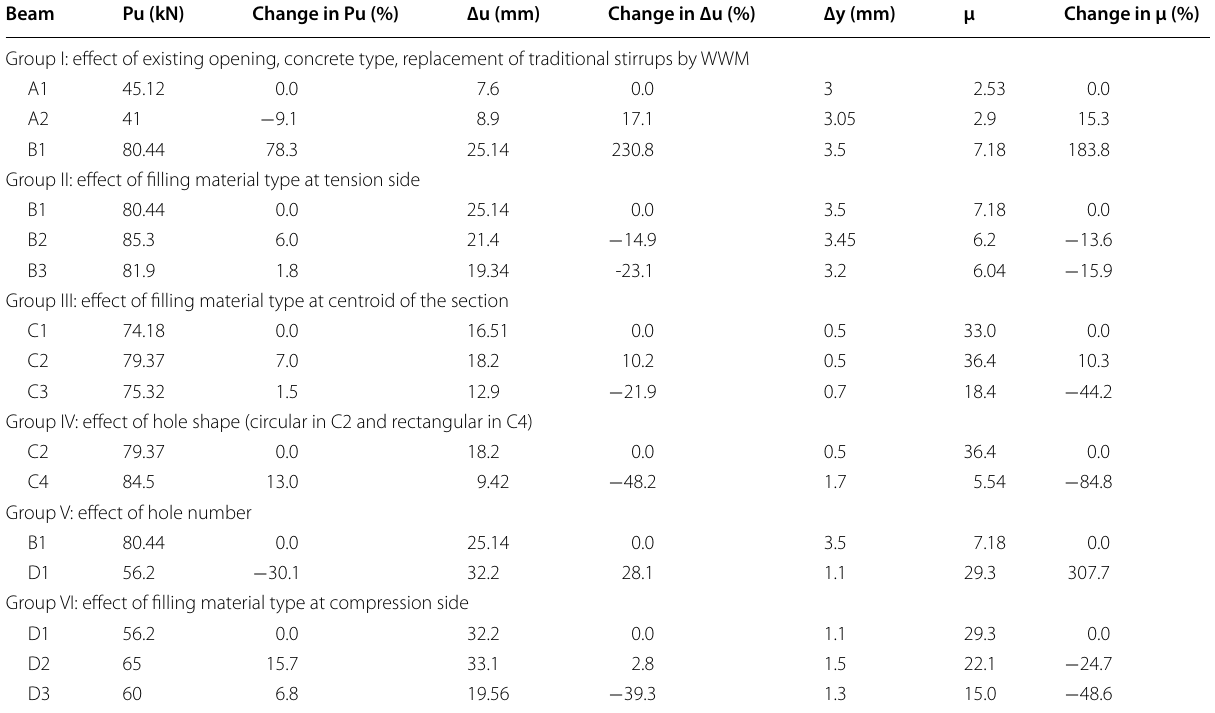
Table 7 Results analysis at ultimate stage